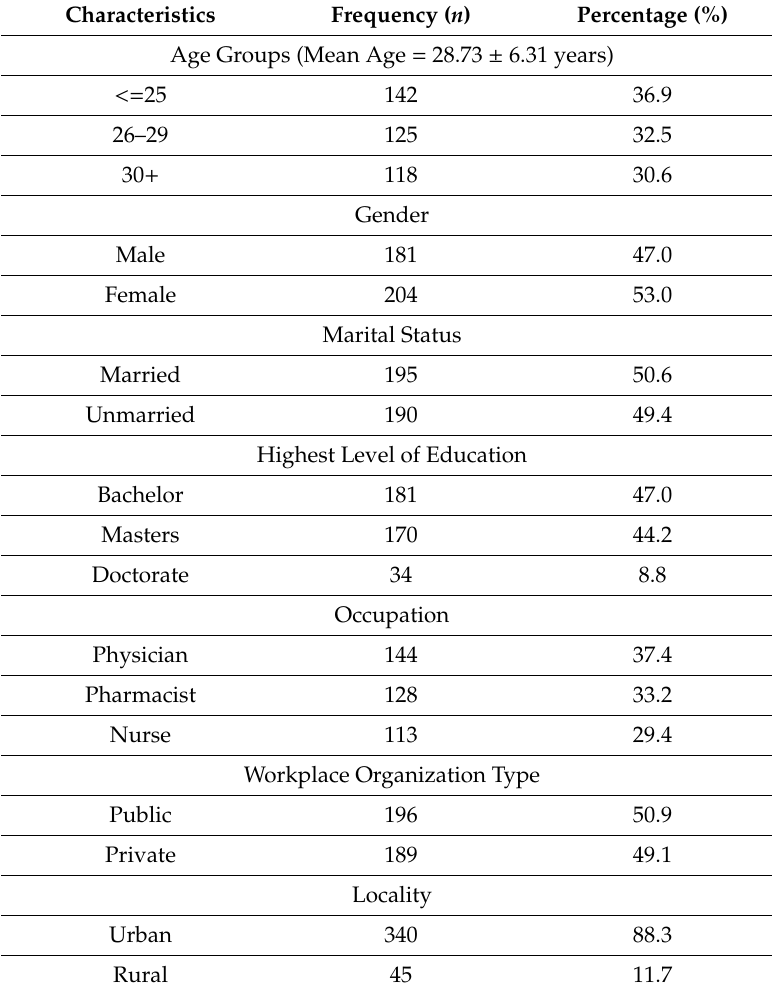
Table 1. Demographic characteristics of study respondents ( N =